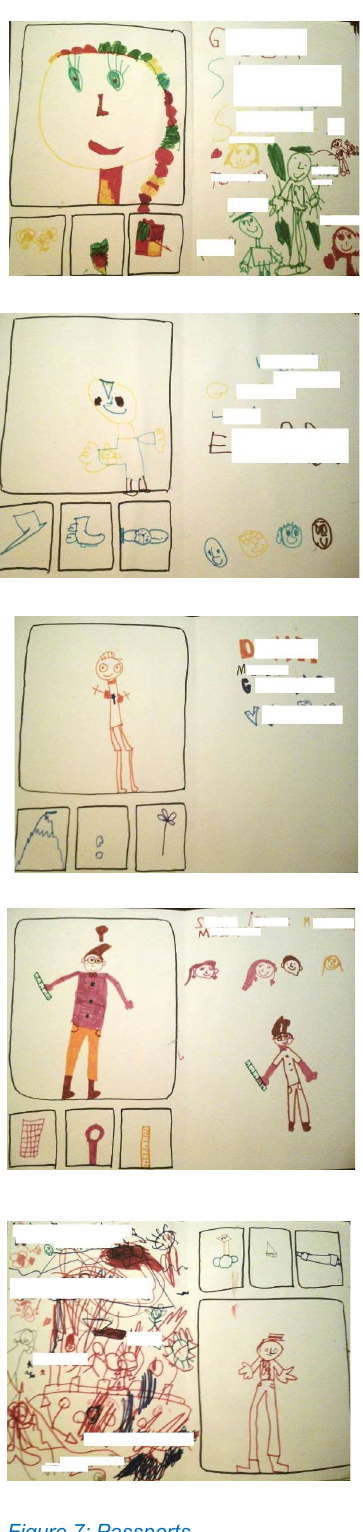
Figure 6: Intergallactic Maps Figure 7: